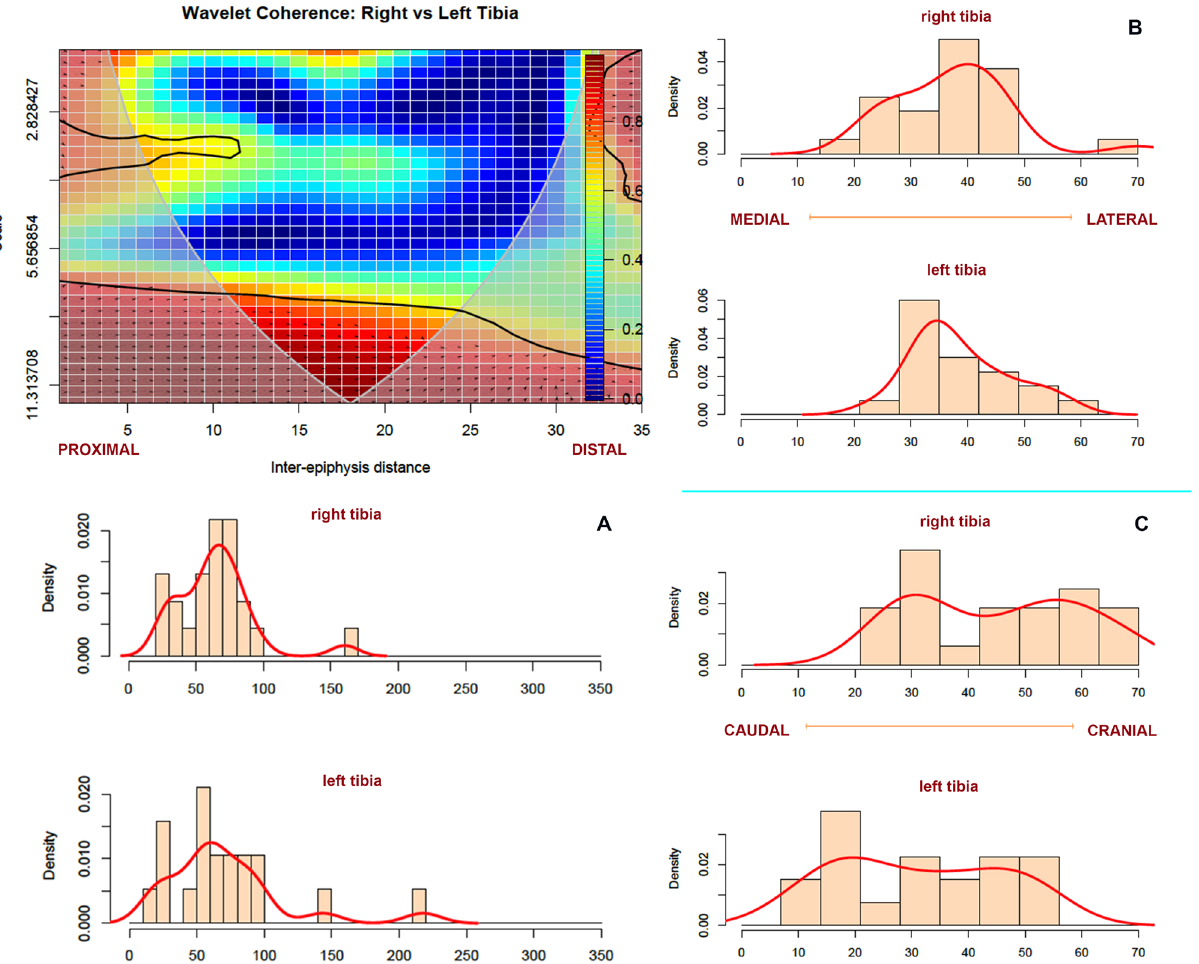
Figure 8. Bivariate wavelet coherence plot showing the correlation of tooth mark damage on the proximal and distal sections of left and right tibiae in moderate to high frequencies. Notice different location of proximal and distal ends compared to the other elements. Arrows indicate that in these two high-correlation areas, both tibial sides are in phase (i.e., the covary together in the same direction). Binning of histograms is described in Table 3. ( A ) frequency of marks from distal end (right) to proximal (left) end; ( B ) frequency of marks from lateral (right) to medial (left), and, ( C ) frequency of marks on caudal(left) and cranial